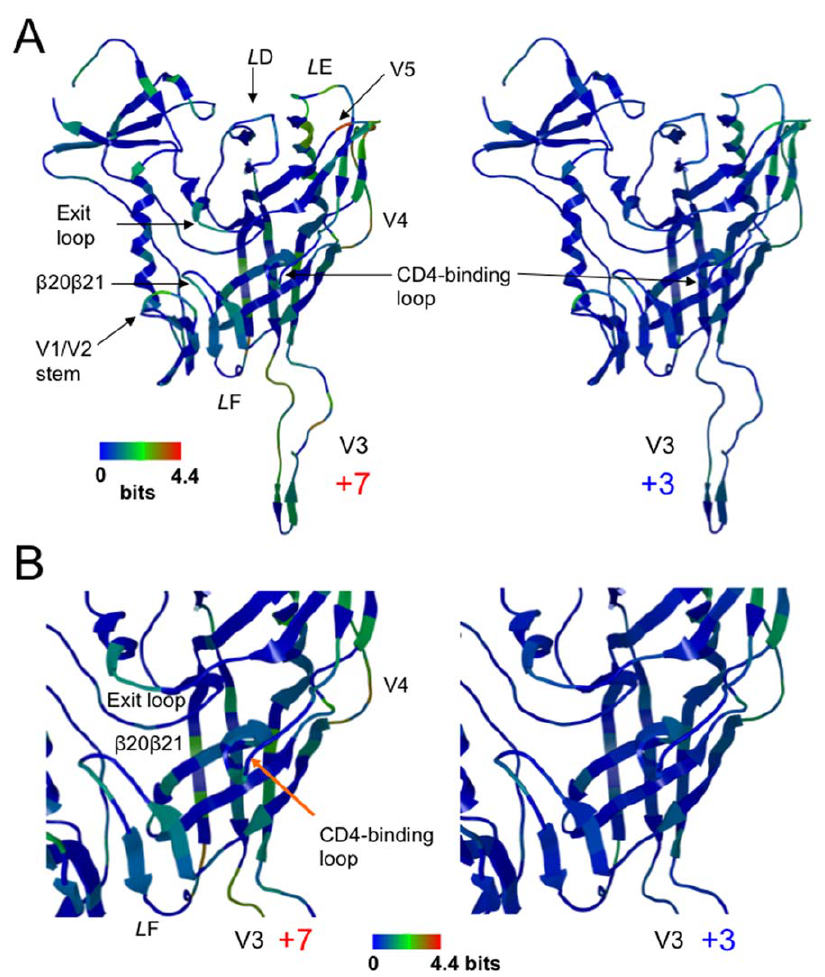
Figure 3. Diversity of the gp120 subpopulations carrying a V3 loop with net charge of + 7 or + 3. Full-length gp120 sequences of the HIV-1 CRF01_AE [42] were extracted from a public database, and divided into subgroups on the basis of the net charge of the V3 loop ( + 2 , + 8). The divided sequences were used to calculate the Shannon entropy, H(i) [63], within each subpopulation, and the H(i) values were plotted on the 3-D structure of gp120 (PDB code: 2B4C [1]). The results for the gp120 subgroups that have V3 loops with + 7 (left panel) and + 3 (right panel) charges are shown as representative. The numbers of sequences used to calculate the H(i) were 9 and 81 for + 7 and + 3, respectively. (A) Distribution of H(i) in the gp120 monomer. (B) Distribution of H(i) around the CD4 binding